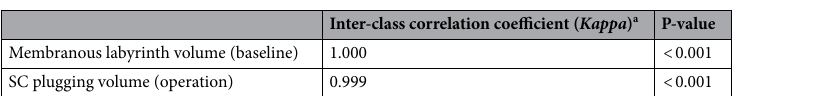
Table 2. Inter-class correlation in the evaluation of the qualitative analysis. a Note that inter-class correlation was performed to determine the consistency of average measures among the rates via Kappa statistic. The consistency level was defined as follows: Kappa < 0.6, poor consistency; 0.4 ≤ Kappa < 0.79, general consistency; and Kappa ≥ 0.80, good consistency; SC, superior semicircular